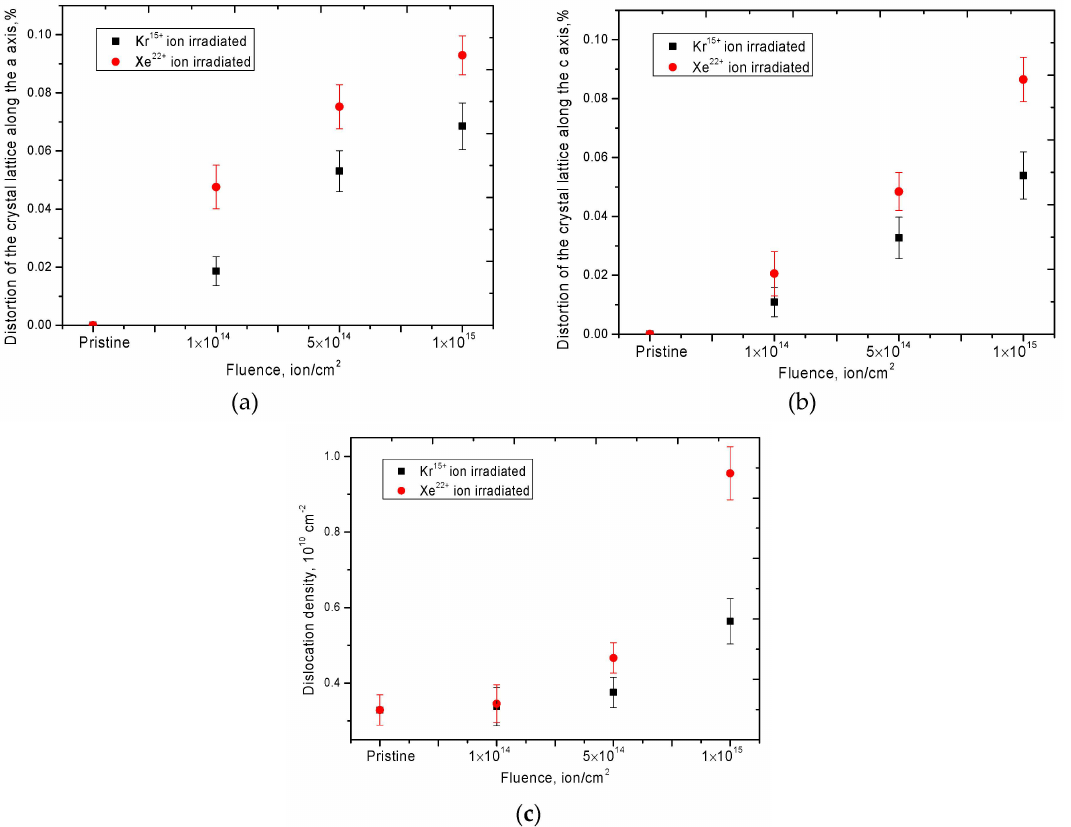
Figure 11. ( a ) Graph of crystal lattice distortion along the a axis; ( b ) Graph of crystal lattice distortion along the c axis; ( c ) The graph of the change of the dislocation density depending on the radiation